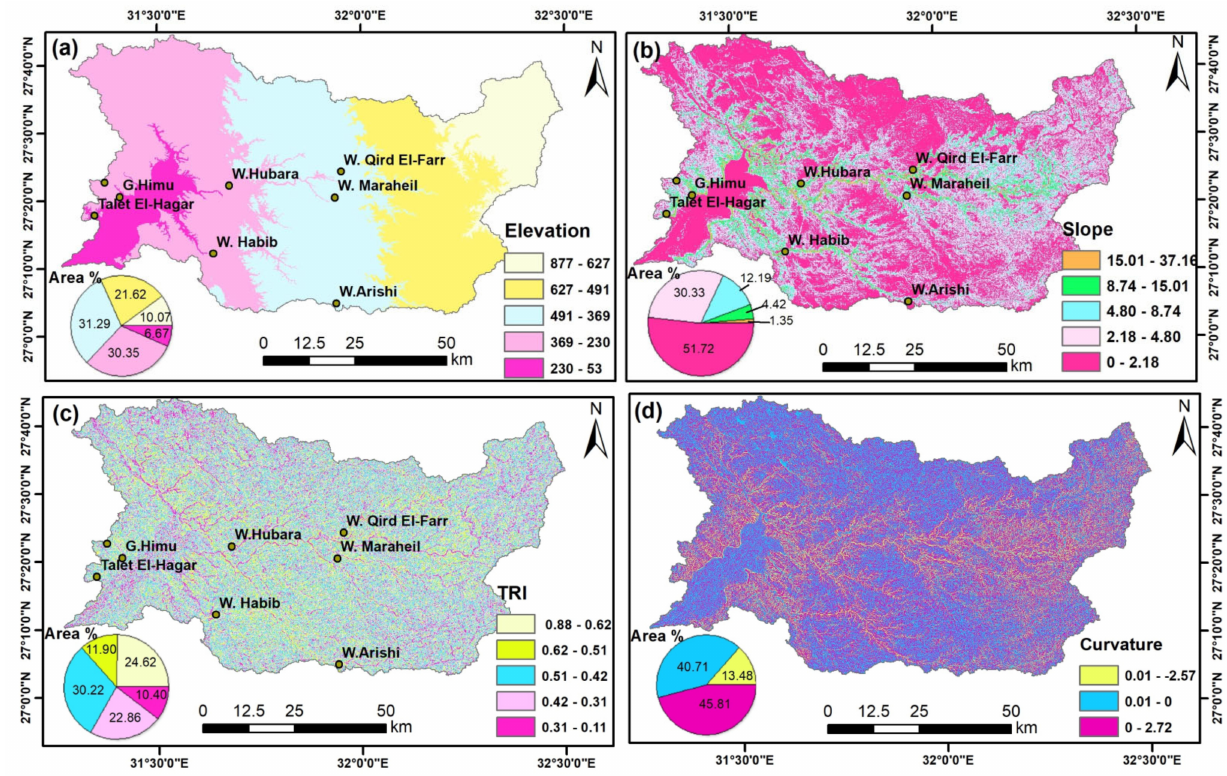
Figure 5. Topographical factors of the W. Asyuti basin ( a ) elevation classes; ( b ) slope degree classes; ( c ) Terrain Roughness Index (TRI); ( d ) Curvature